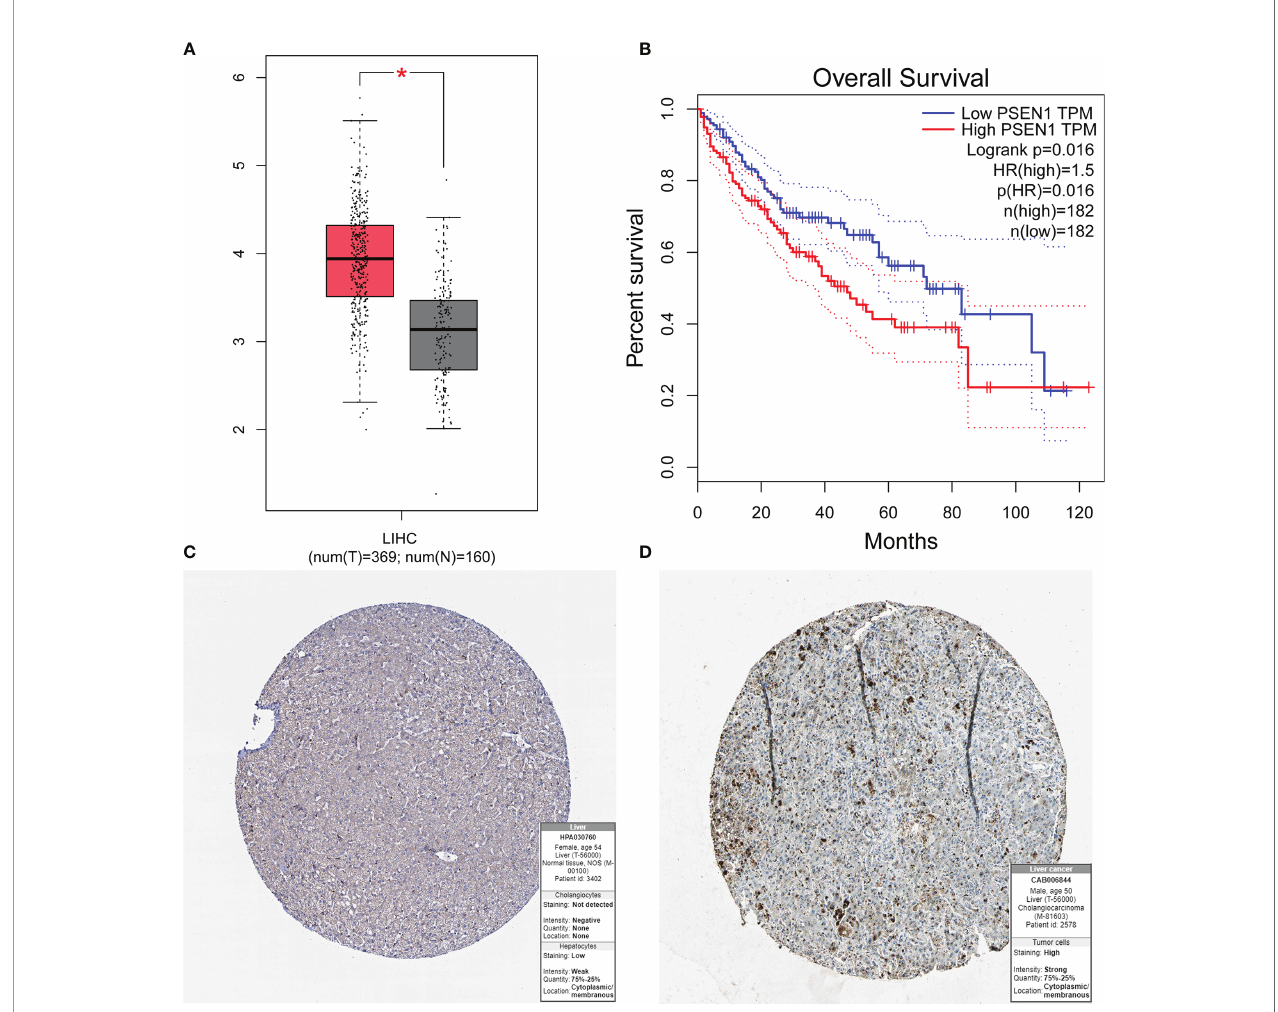
FIGURE 9 | The expression of PSEN1 in HCC and the prognosis based on the GEPIA and HPA databases. (A) High expression of PSEN1 based on the GEPIA database; (B) Overall survival analysis based on the GEPIA database; (C) The normal liver tissues based on the HPA database; (D) The tumor liver tissues based on the HPA database. * indicate P <